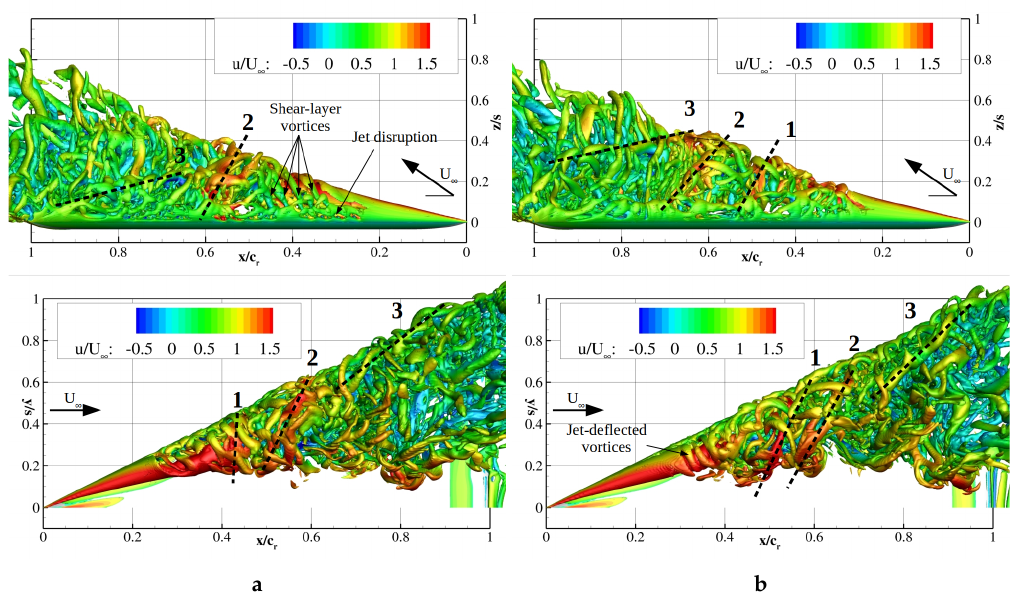
Figure 14. Q-criterion Q = 10 5 s − 2 at α = 35 ◦ ( a ) during blowing and ( b ) T /2 after